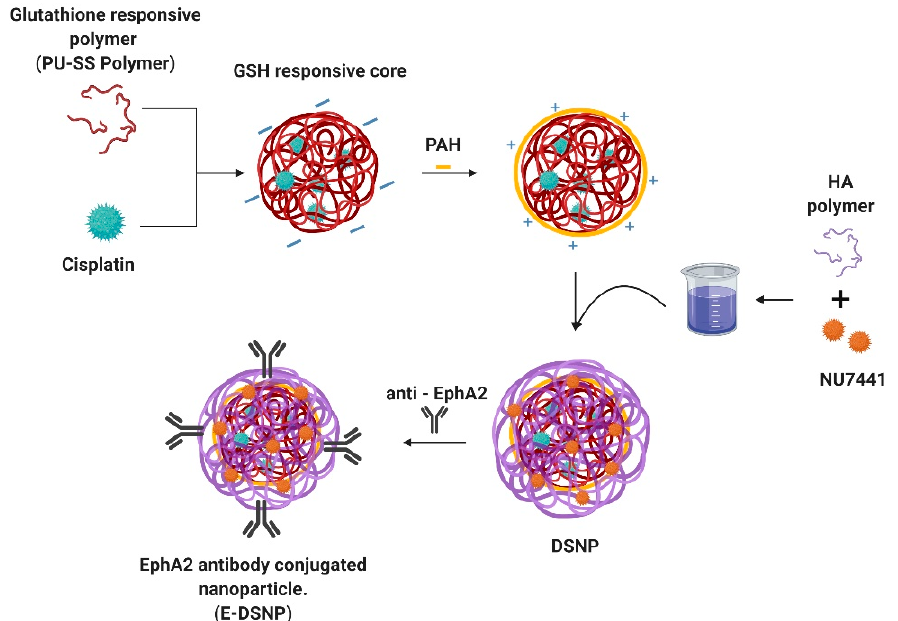
Figure 1. Schematic of core-shell E-DSNPs synthesis by an electrostatic layer-by-layer coating tech-